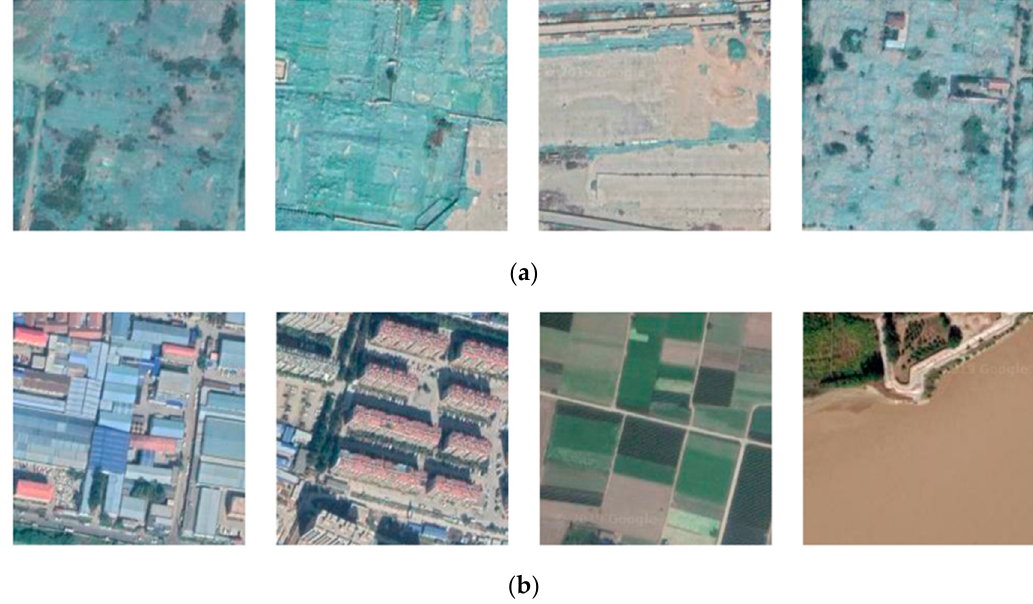
Figure 3. Samples of each land cover category: ( a ) Green plastic cover (GPC); ( b ) non-GPC.